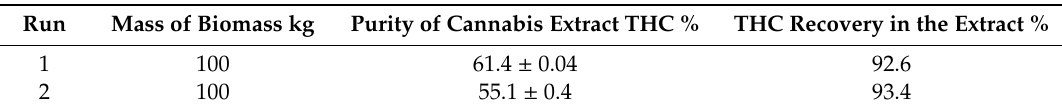
Figure 4. Schematic of the MAP TM cannabis extraction & acidic cannabinoids decarboxylation.